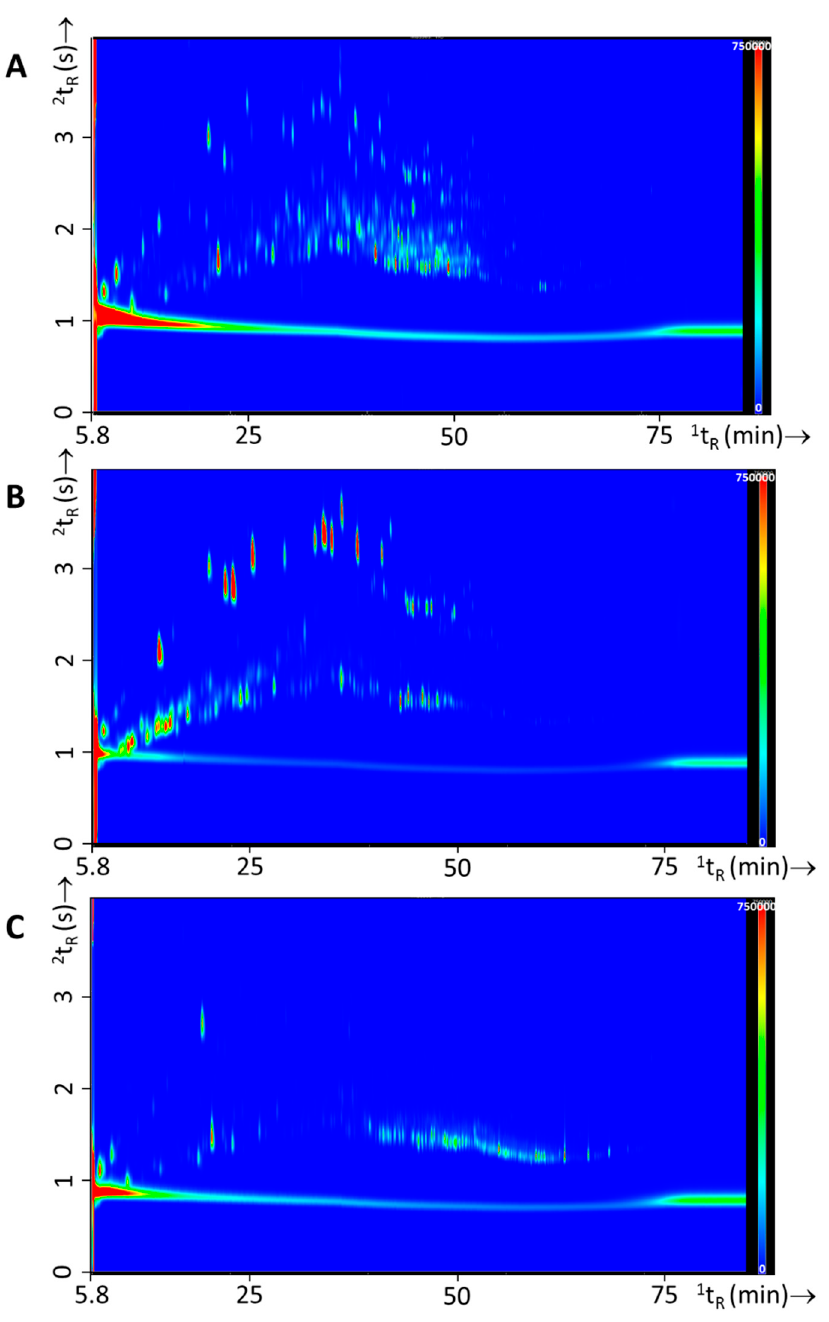
Figure 8. Typical GC × GC-TOFMS TIC contour plots for fire debris experiments with IL, with ( A ) experiment 69—white spirit, ( B ) experiment 83—gasoline, and ( C ) experiment 105—lamp oil.